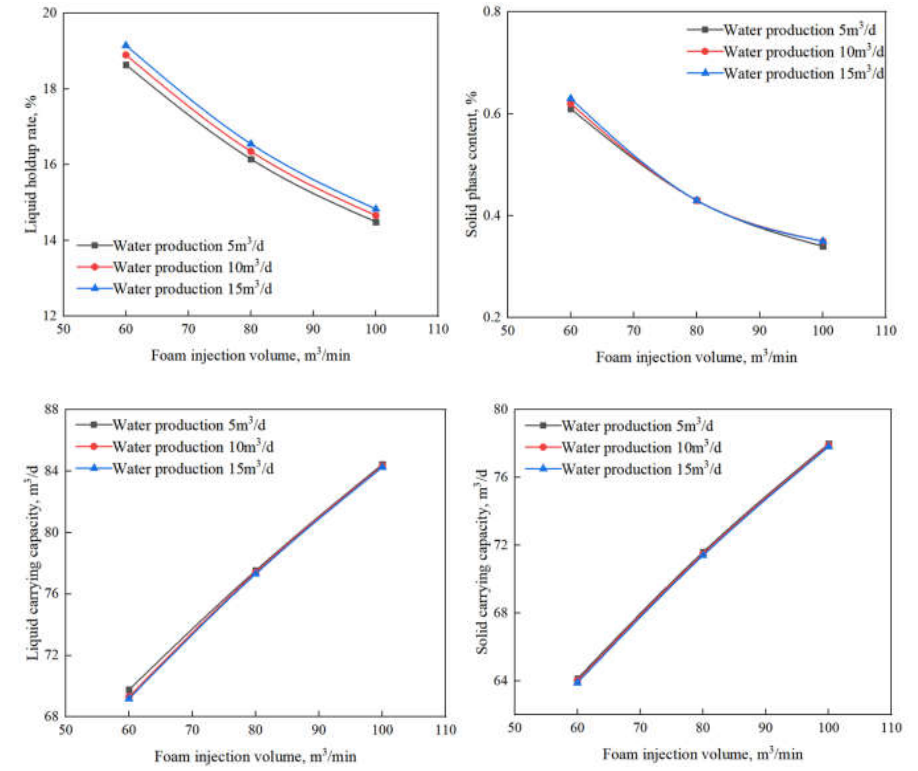
Figure 4. Variation rules of parameters under different foam injection volume at different water production amounts.